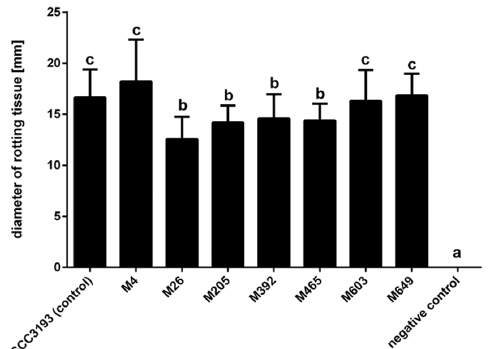
Figure 6. Maceration of potato tuber tissue by phage ‐ resistant P. parmentieri mutants. The average diameter of rotting (in mm) measured after 72 h incubation at 28 °C in a humid box is shown. Three individual potato tuber slices were inoculated per mutant in two independent experiments ( n = 18; three wells per strain per slice and per experiment). Results considered significant at p = 0.05 and pair ‐ wise differences were obtained using the t ‐ test. The means that do not share the same letters above each bar differ. Vertical lines represent standard deviation (SD).